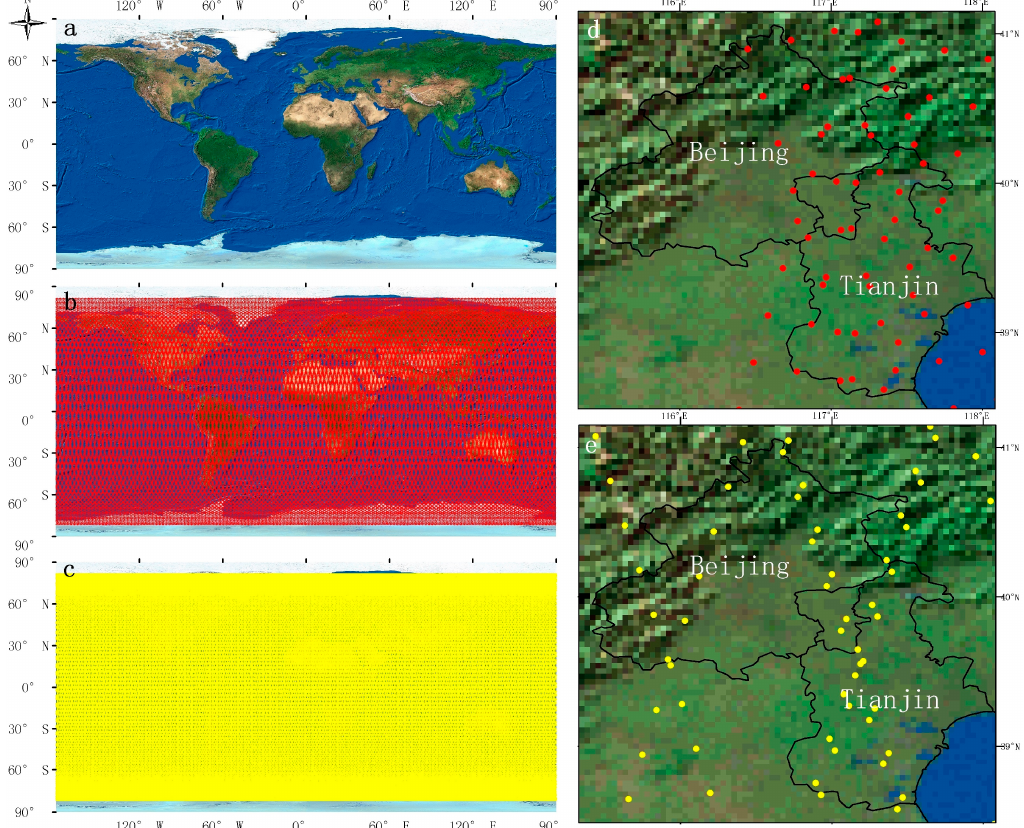
Figure 4. Coverage of the CO 2 -IDPA for one month using different orbit altitudes. Red and yellow spots represent the nadirs collected using orbit altitudes of 450 and 705 km, respectively. The figure shows the base map ( a ), and the global distribution of 450 km ( b ) and 705 km ( c ) samples. ( d , e ) The regional distribution of nadir samples in Beijing and Tianjin.